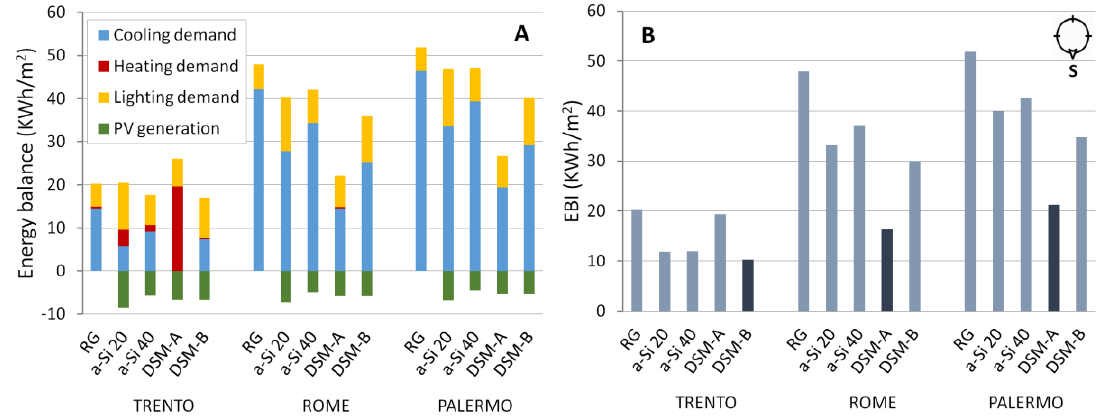
Figure 8. ( A ) Energy balance for the various STPV tested, compared to the reference glass (RG) of the STD building with southern exposure at the three locations; ( B ) EBI index evaluated for the same exposure and glazing elements.